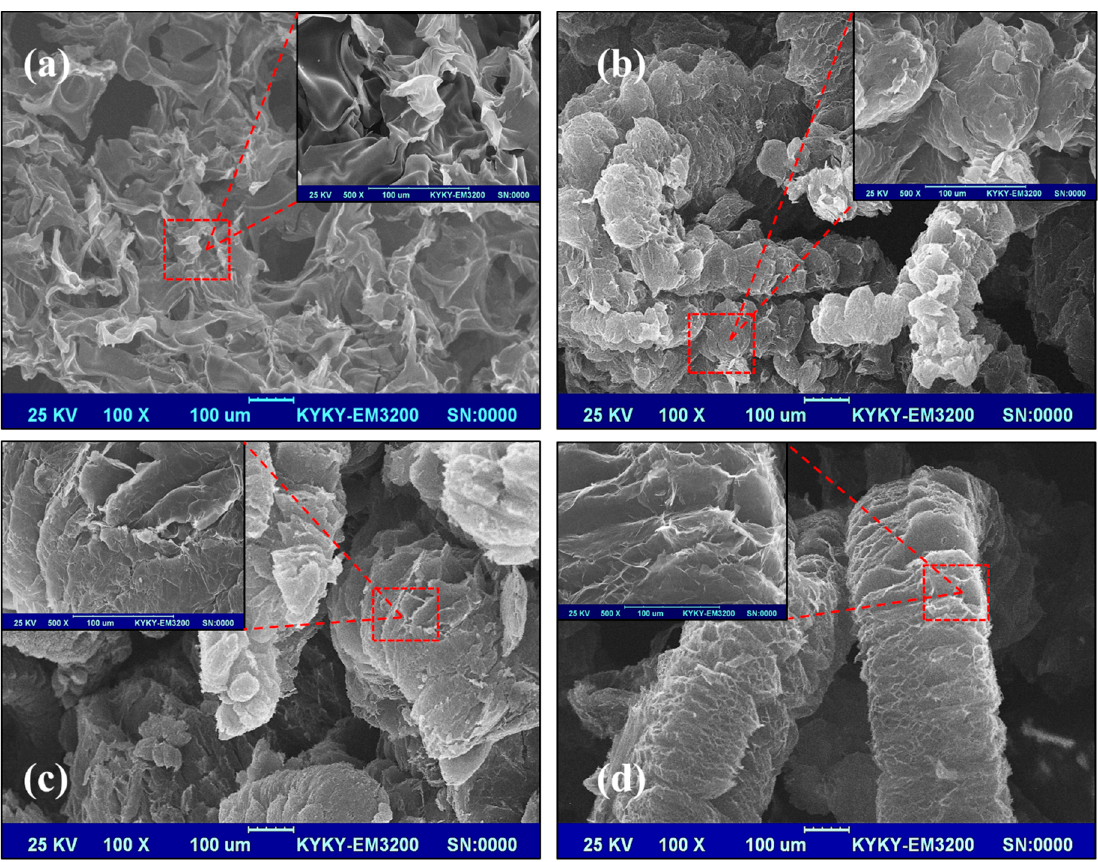
Figure 6. Scanning electron microscopy (SEM) images of the residues of RPUF samples: ( a ) RPUF; ( b ) FRPU; ( c ) FRPU/GO; and ( d ) FRPU/fGO.